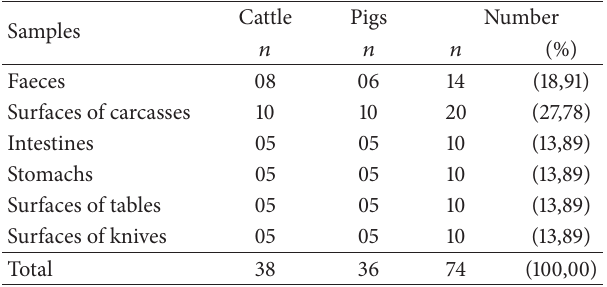
Table 1: Situation of samples collected.